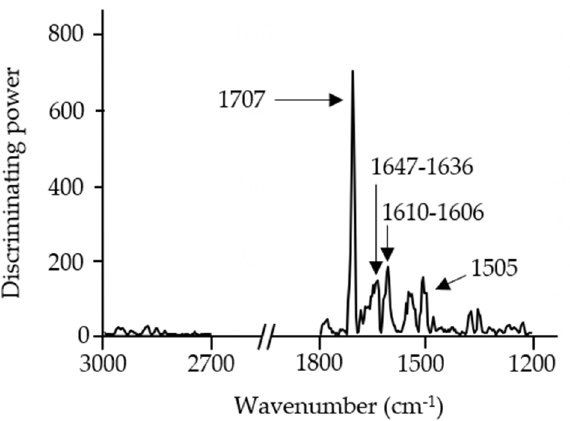
Figure 10. Soft independent modeling of class analogy discriminating power plot of FTIR spectroscopy spectra (3000–2700 cm − 1 and 1800–1200 cm − 1 ) from a 4-class SIMCA A. diaperinus snack model. Table 9. Soft independent modeling of class analogy interclass distances from a 4-class SIMCA A. diaperinus snack model. Abbreviations used: Bs, blank snack with 0% insect powder; As 1 , snack with